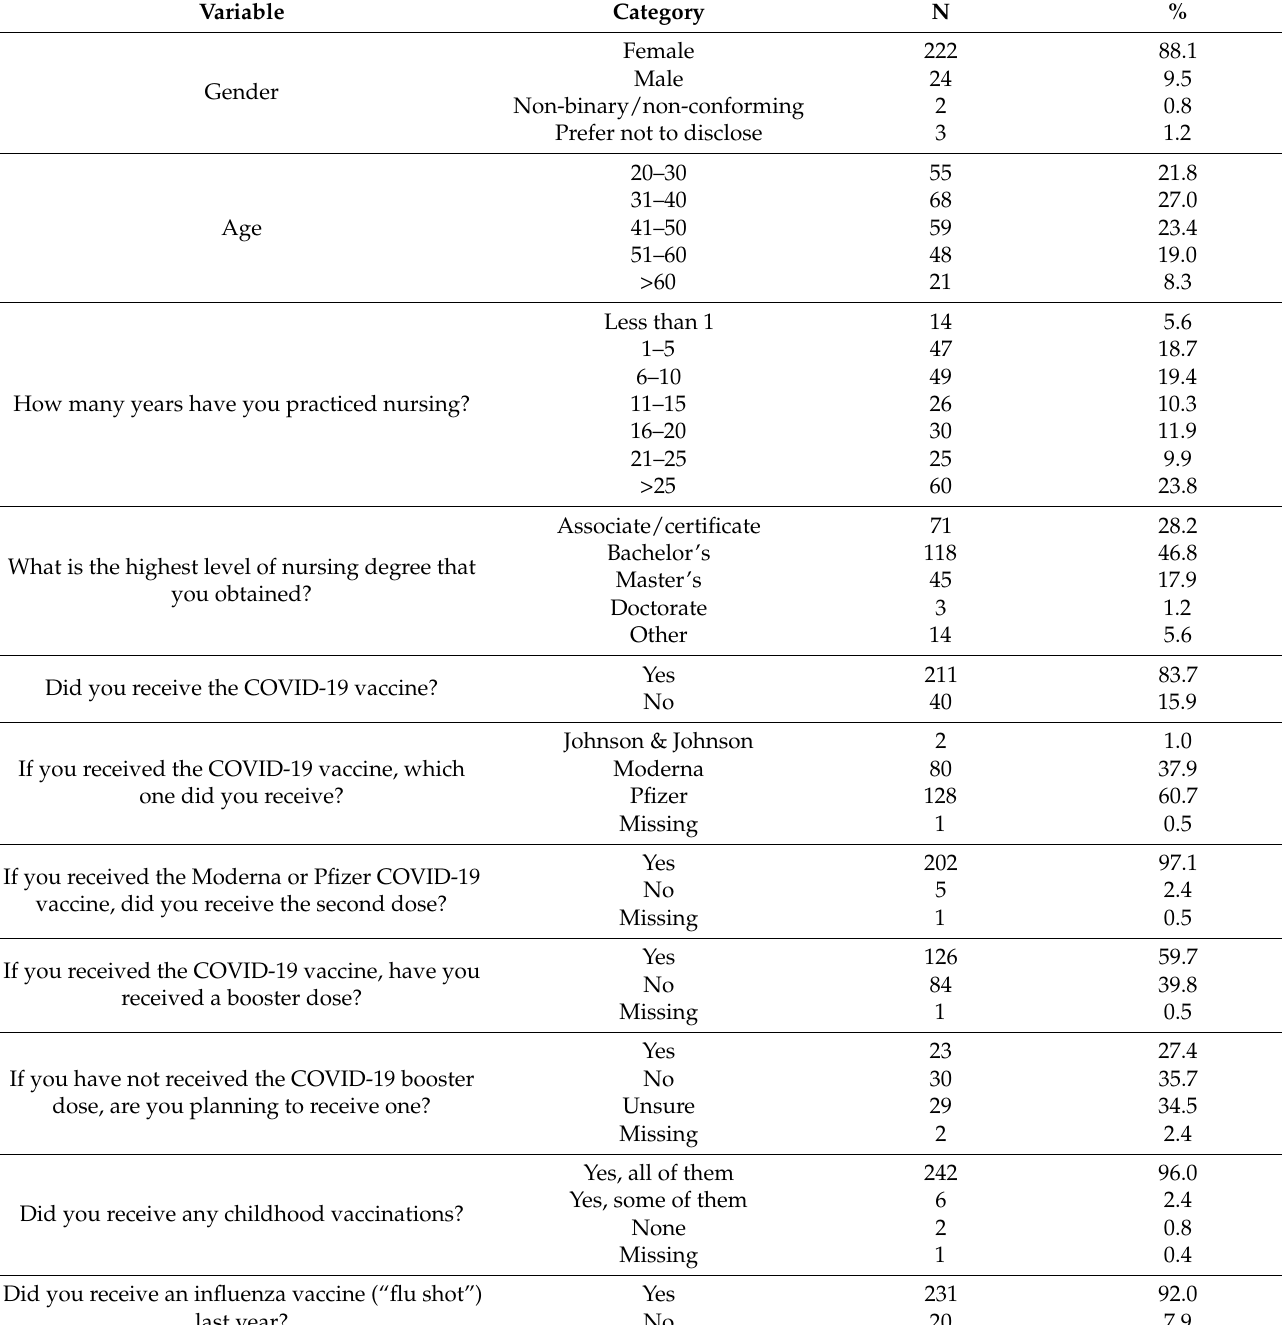
Table 1. Basic demographics and answers to vaccination survey